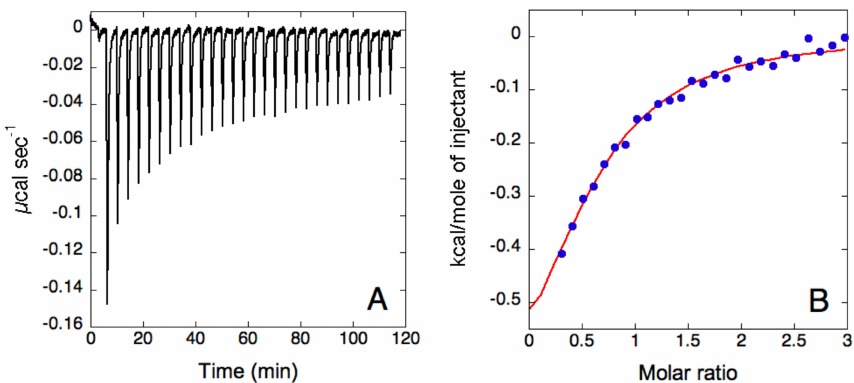
Figure 2. Isothermal titration calorimetry analysis of Tween ® 20 and β -glucosidase. ( A ) Raw titration data of Tween ® 20 (0.5 mM) titrated over β -Glu (37 µ M) in PBS buffer, pH 6. ( B ) Binding isotherm of Tween ® 20 titration over β -Glu, obtained by integrating raw data for the protein titration. The blue dots represent the experimental data and the red curve represents the fit of the data using a single set of sites model.